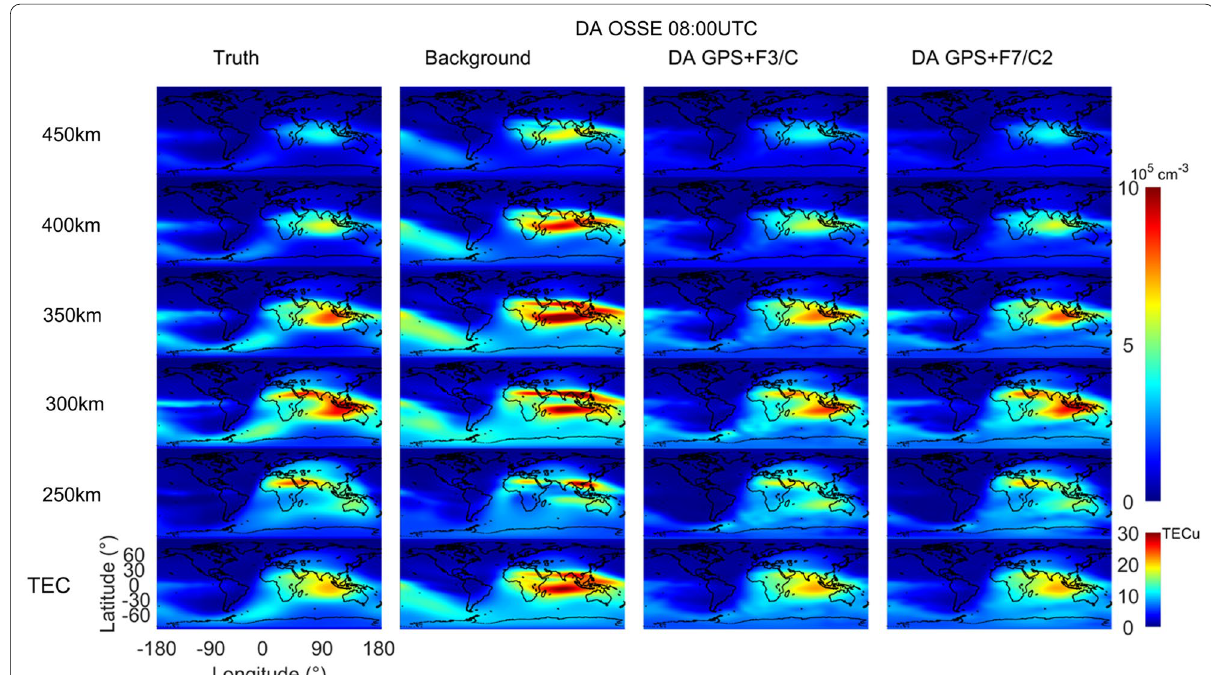
Fig. 11 Comparison of OSSEs for F3/C and F7/C2 with ground‑based GPS at 0800 UT on 15 December 2008. From left to right are the truth (SAMI3 simulation), background (IRI), assimilation analysis for F3/C plus GPS data, and assimilation analysis for F7/C2 plus GPS data. The vertically integrated TEC maps and electron density distributions from bottom to top at altitude 250, 300, 350, 400, and 450